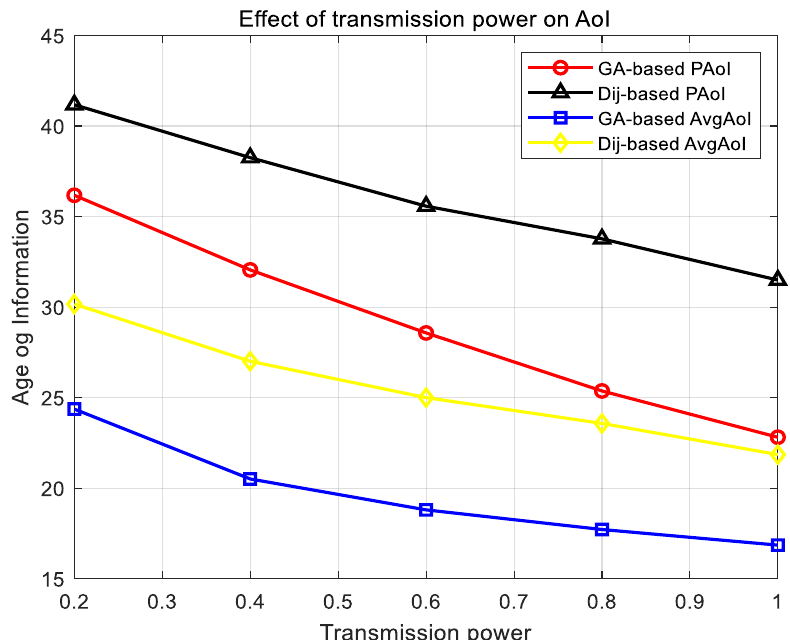
Figure 6. Influence of the UAV transmission power on AoI.